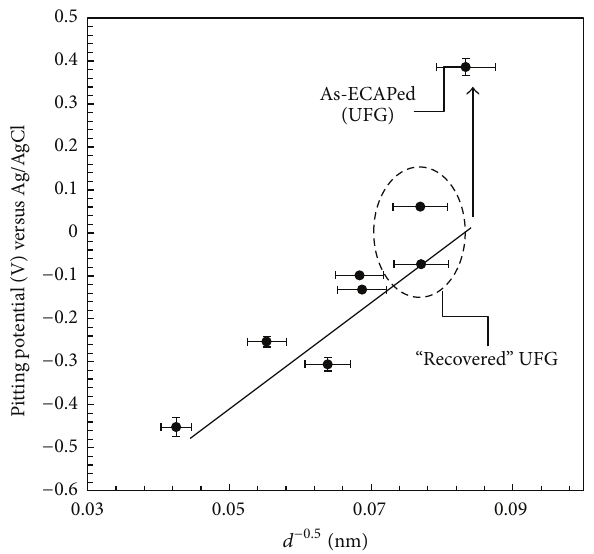
Figure 13: Relationship between pitting potential (V) versus Ag/AgCl and